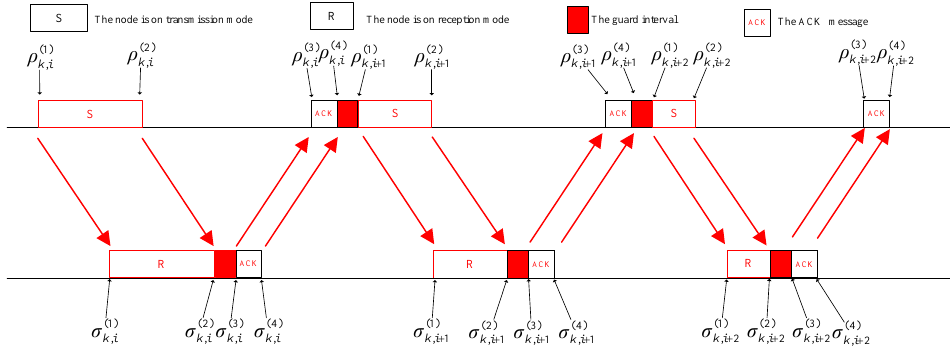
Figure 1. The S&W ARQ scheme with